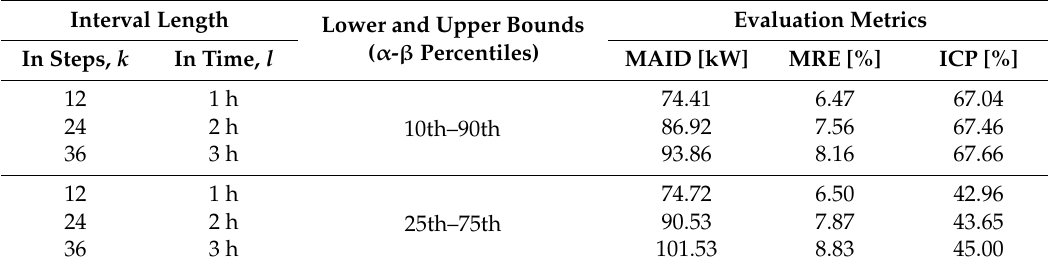
Table 4. Accuracy results for